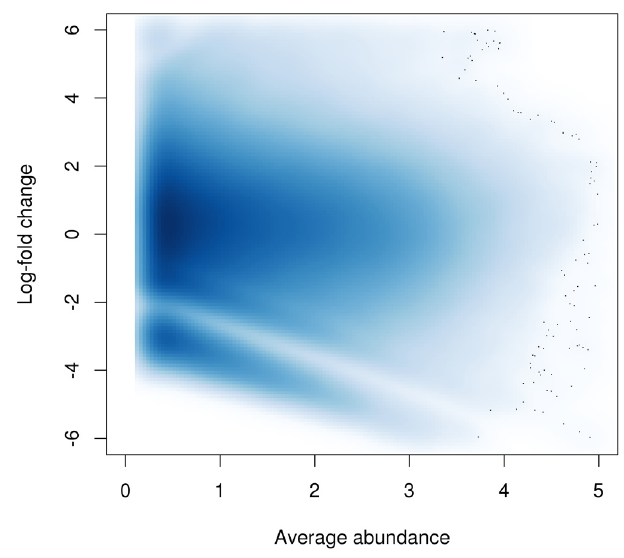
Figure 4. Effect of non-linear normalization on the trended bias between two H3K9ac libraries. Normalized log-fold changes are shown for all windows retained after filtering.